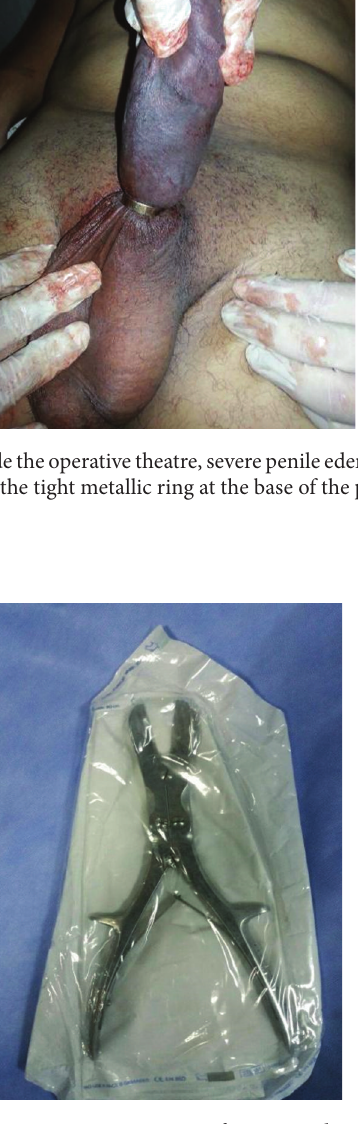
Figure 2: Bone cutting forceps used.